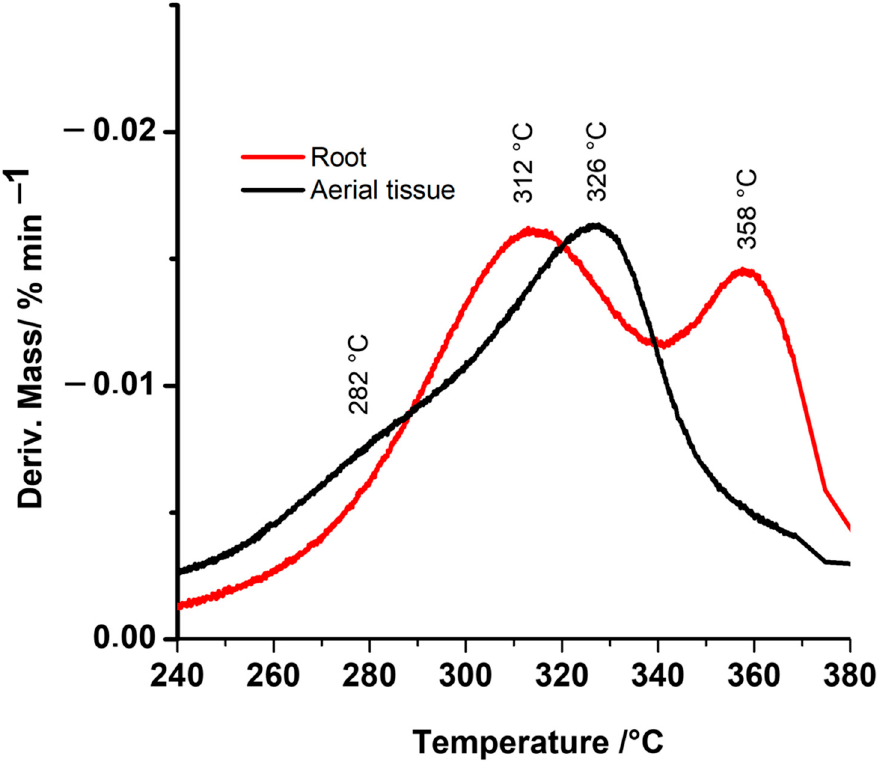
Figure 2. First derivative of the thermogram curves (DTG − TGA thermogram). DTG − TGA shows the maximum degradation temperatures of each cell wall component in the different tissues.